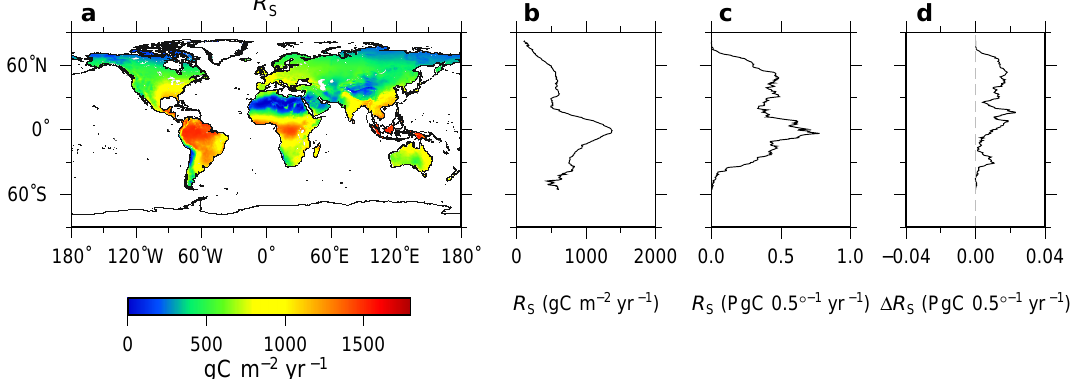
Figure 2. Spatial distribution of the estimated annual soil respiration (a) , the latitudinal patterns of soil respiration components (b, c) , and the difference between the earlier (1965–1989) and later (1990–2012) periods of the simulation (d) .